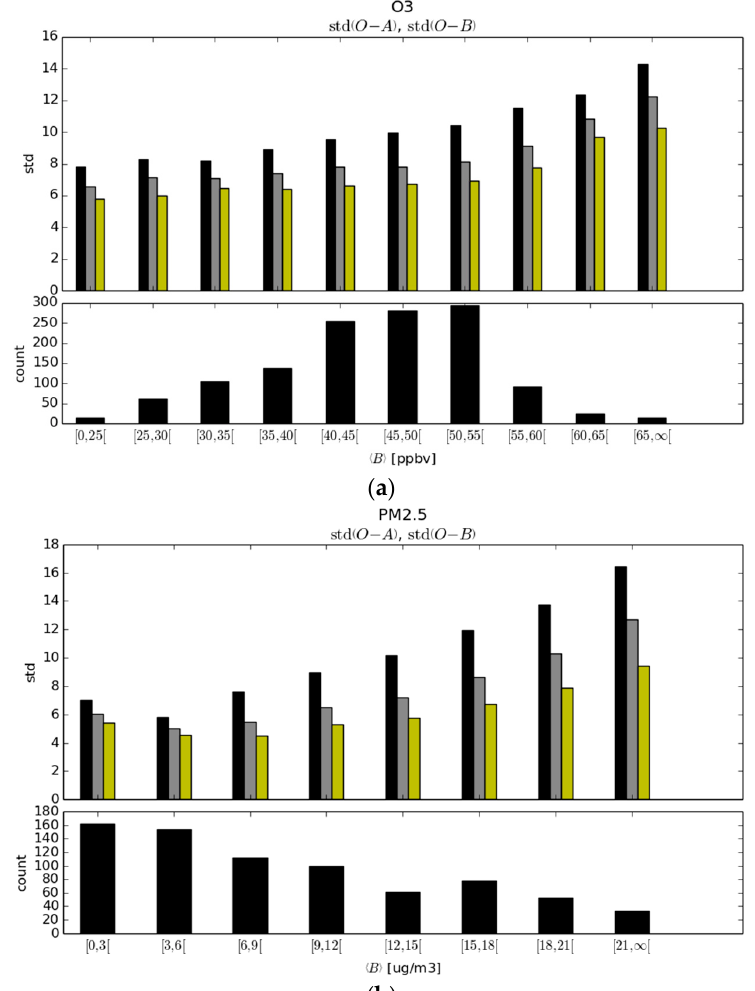
Figure 8 . Same as Figure 6 except that we display the variance of analysis-minus-passive observations per bin of model values.